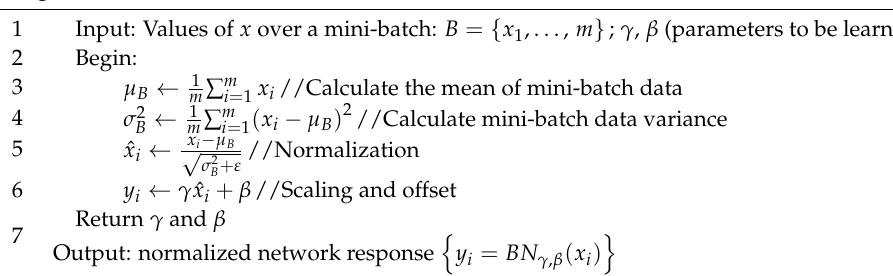
Algorithm 1: Batch